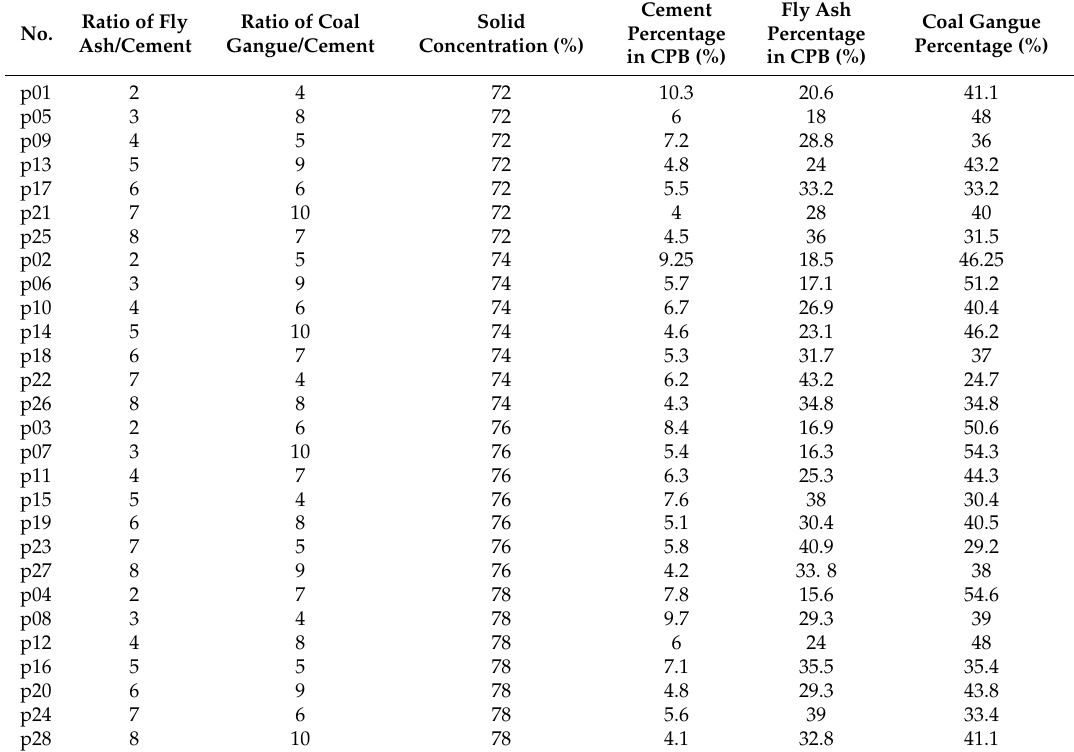
Table 2. Cemented paste backfill (CPB) mixture